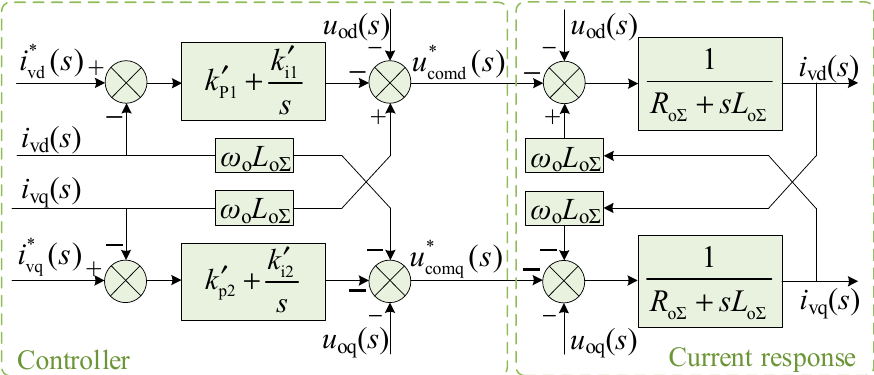
Figure 4. Block diagram of current tracking controller on the output side of M3C.